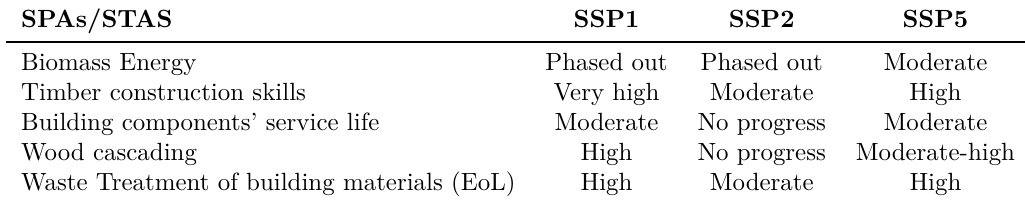
Table 2. Shared Policy Assumptions (SPAs) and Shared Technology Assumptions (STAs) included in the model based on national